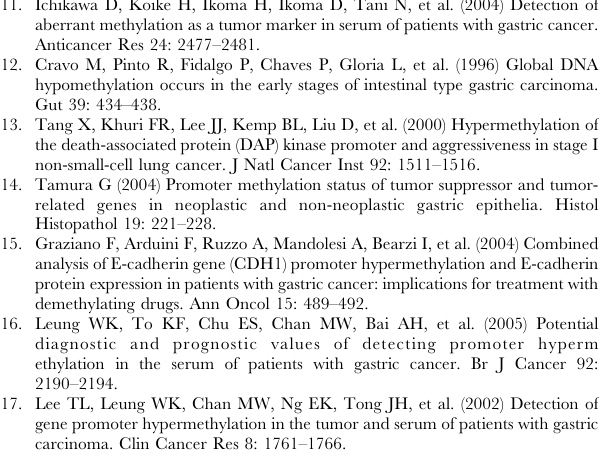
Table S1 The association between global DNA methylation and specific gene methylation and clinicoplatological features.